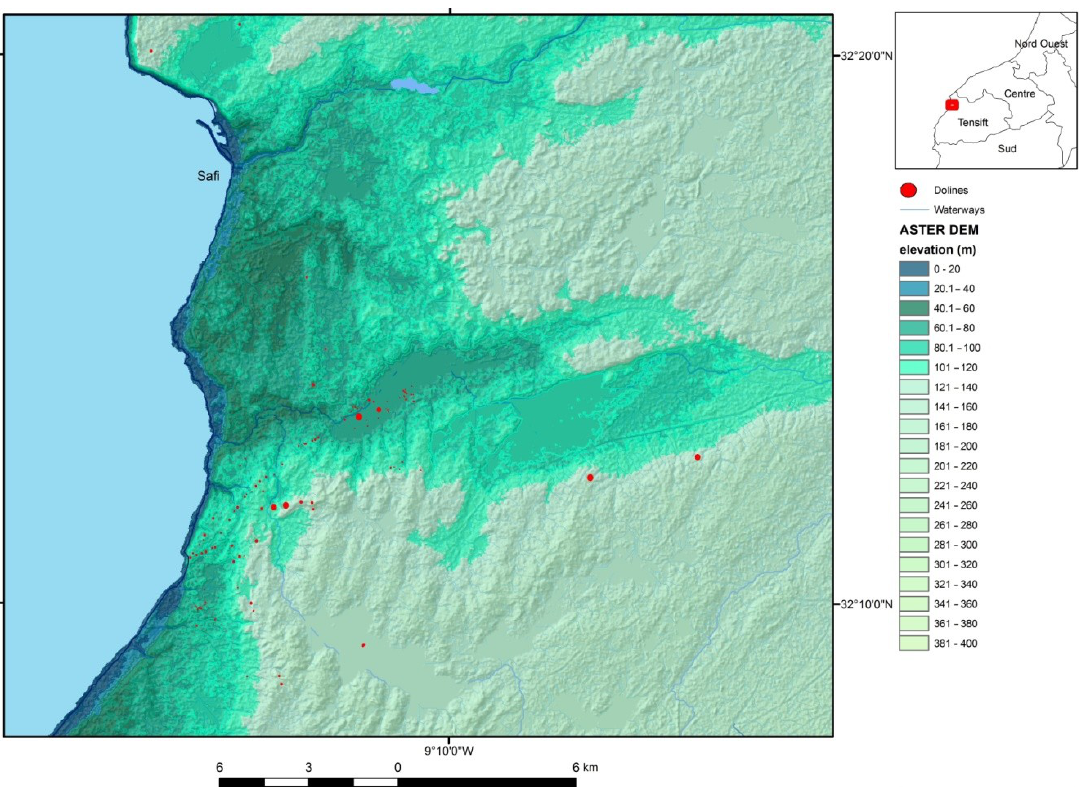
Figure 4. Height level map (elevation above sea level) of the investigation area (dolines: red